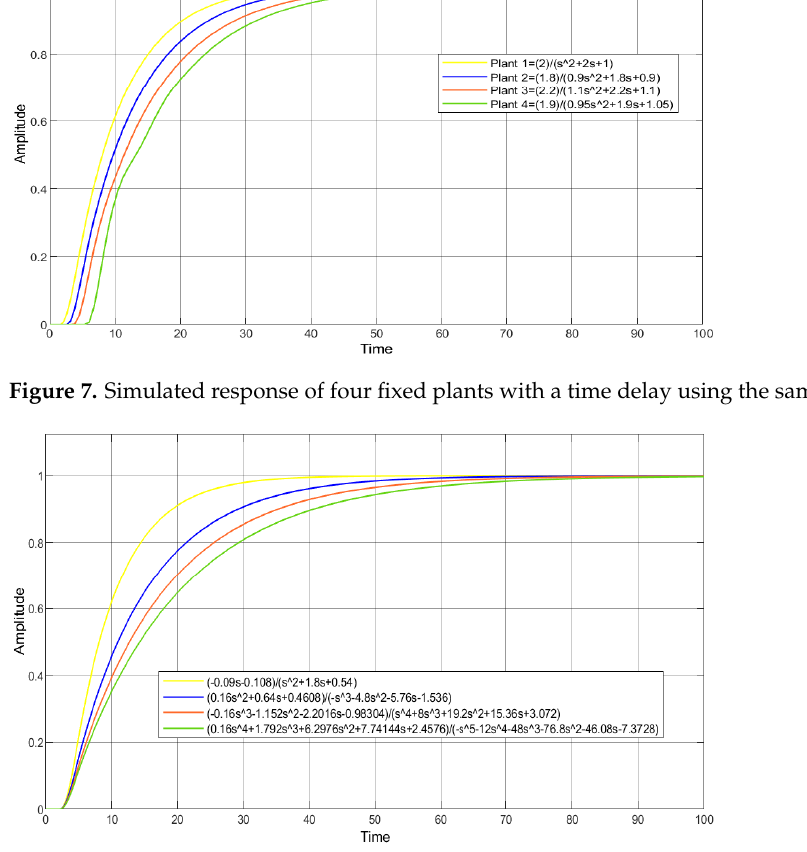
Figure 8. Simulated response under a desired reference step using different controllers.